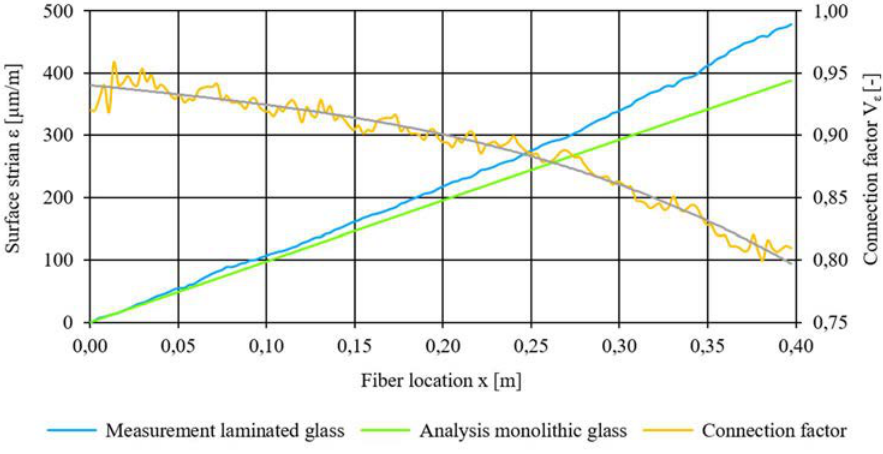
Fig. 7 Surface stress of four-point bending test and calculation as well as the determined connection